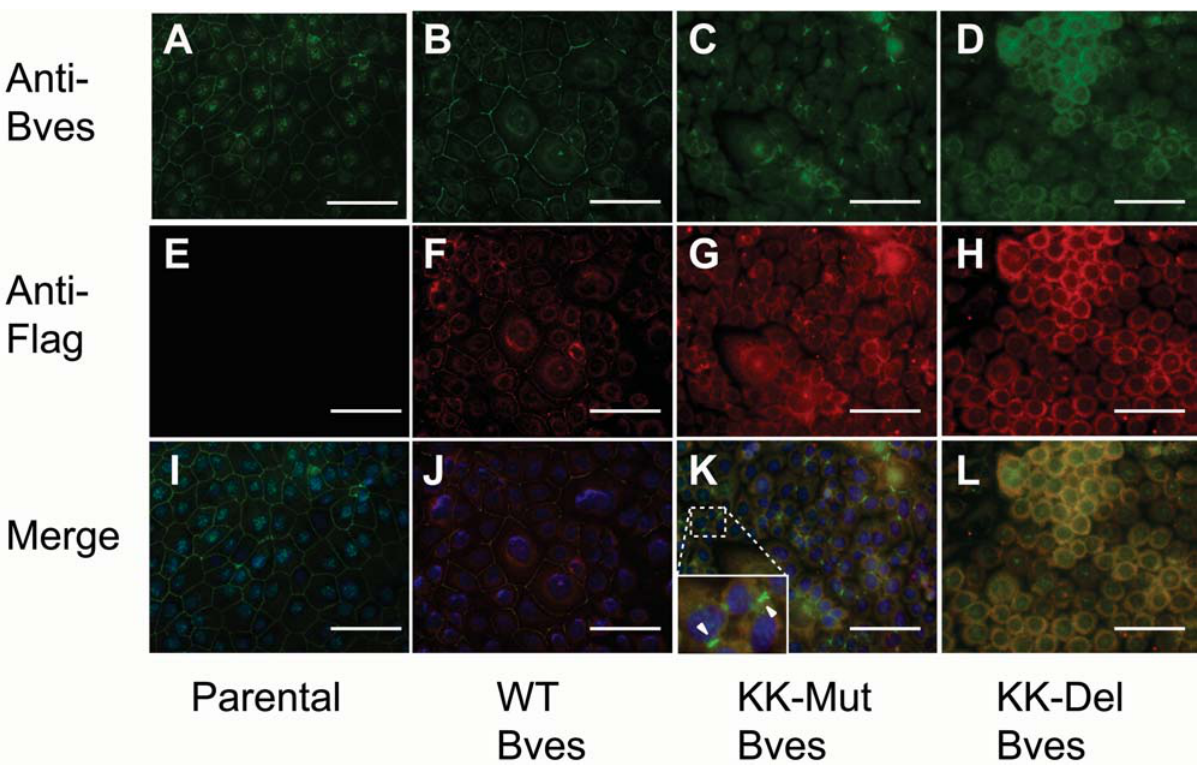
Figure 6. Detection of endogenous and transfected Bves in human corneal epithelial cells (HCE). Anti-Bves staining (top panels, A–D), anti-Flag staining (middle panels, E–H) and merge (bottom panels, I–L) are shown. A, Endogenous Bves is detected at the parental cell membrane in confluent monolayers. E, Parental cells do not react with anti-Flag. B, Endogenous Bves is expressed in WT Bves transfected cells. F, Transfected WT Flag-tagged Bves traffics to the cell membrane J, where it co-localizes with anti-Bves staining, which detects endogenous protein. C, G, K, Transfection of KK-Mut Bves and D, H, L, KK-Del Bves show a general loss of membrane staining for both endogenous and transfected protein. Inset K, importantly, sporadic green staining at the membrane is seen in merged images with transfected KK-Mut Bves suggesting localization of endogenous but not